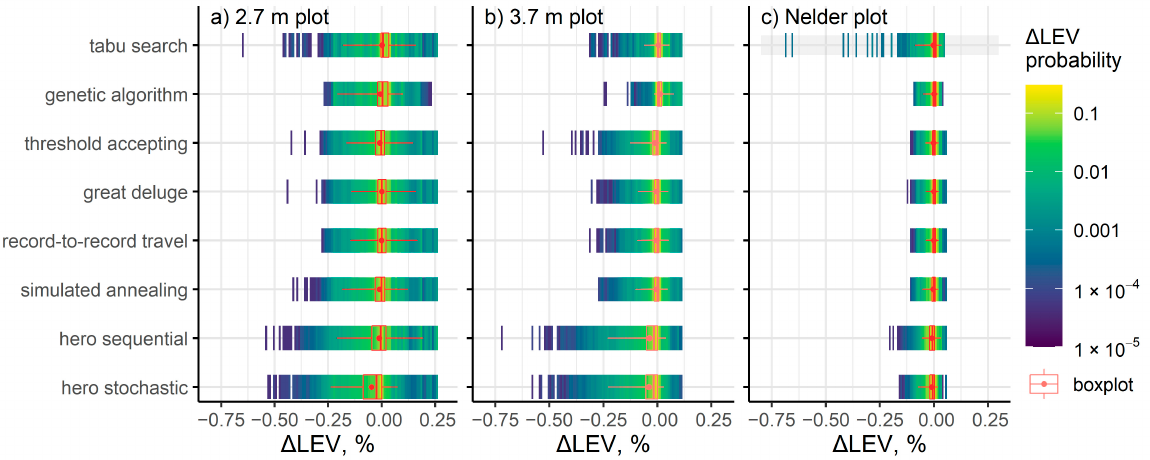
Figure 3. Empirical distributions of the differences ( ∆ LEV) between a plot’s median LEV and the LEVs obtained from 531,300 individual heuristic runs. Each heuristic was run 23,000 times on each plot, except for tabu search on the Nelder plot, which was limited to 2300 runs due to its computational cost (light grey shading); 98.8% of the runs converged within ± 0.2% of the median LEV. The largest differences of − 0.65%, − 0.72%, and − 0.69% were outliers on the 2.7 m, 3.7 m, and Nelder plots,